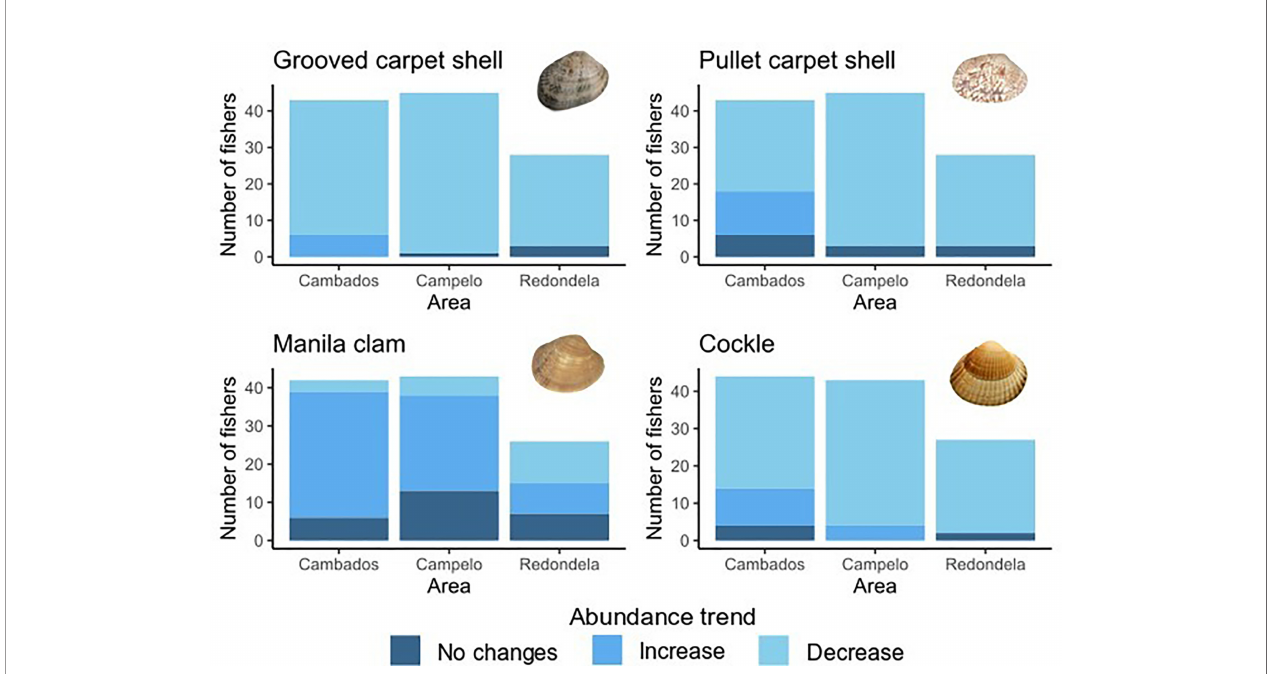
FIGURE 3 | Fishers ’ perceptions about the abundance of key commercial shell fi sh species.